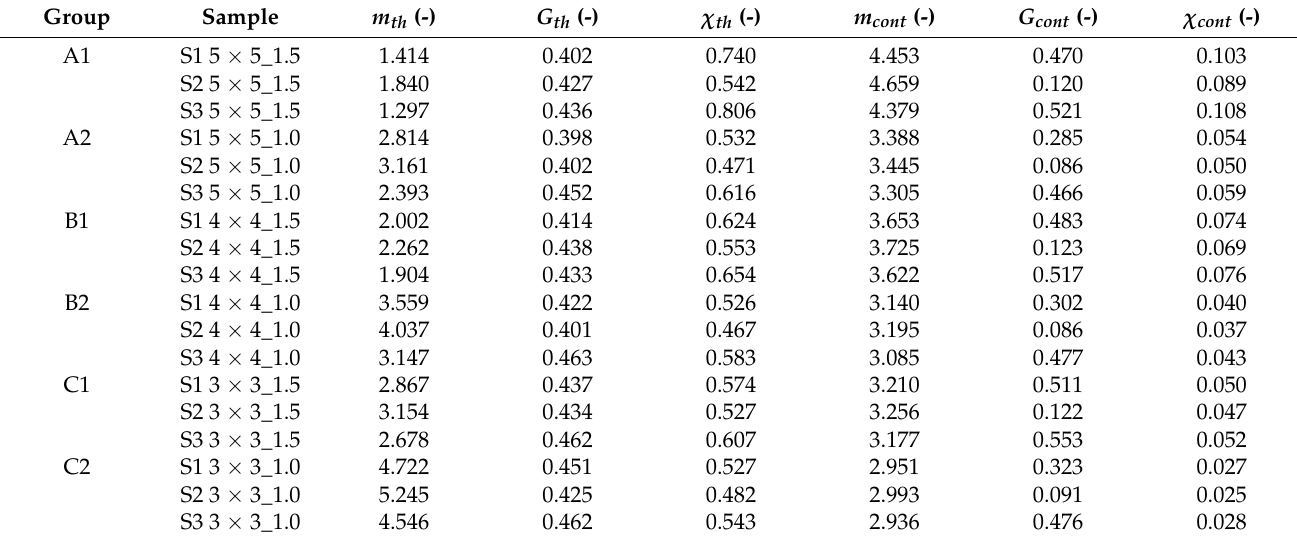
Table 6. Characterisation of phases of woven structures.